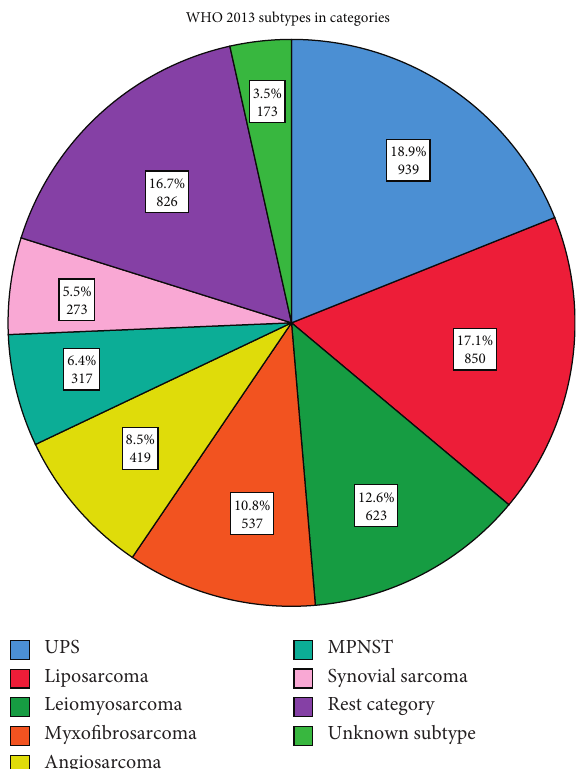
Figure 1: Overview of histological subtypes of grade II and III resected soft tissue sarcoma in the Netherlands between 2000 and 2017. Abbreviations: UPS � undifferentiated pleomorphic sarcoma, MPNST � malignant peripheral nerve sheath tumor.